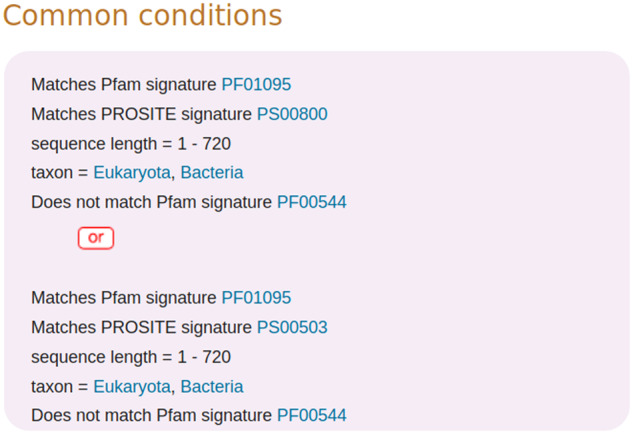
The common conditions in a UniRule rule. Rule UR000000256 contains two sets of conditions that make up the common conditions. Within each set, the conditions are connected by the logical operator ‘AND’, while the two sets are connected by the logical operator ‘OR’